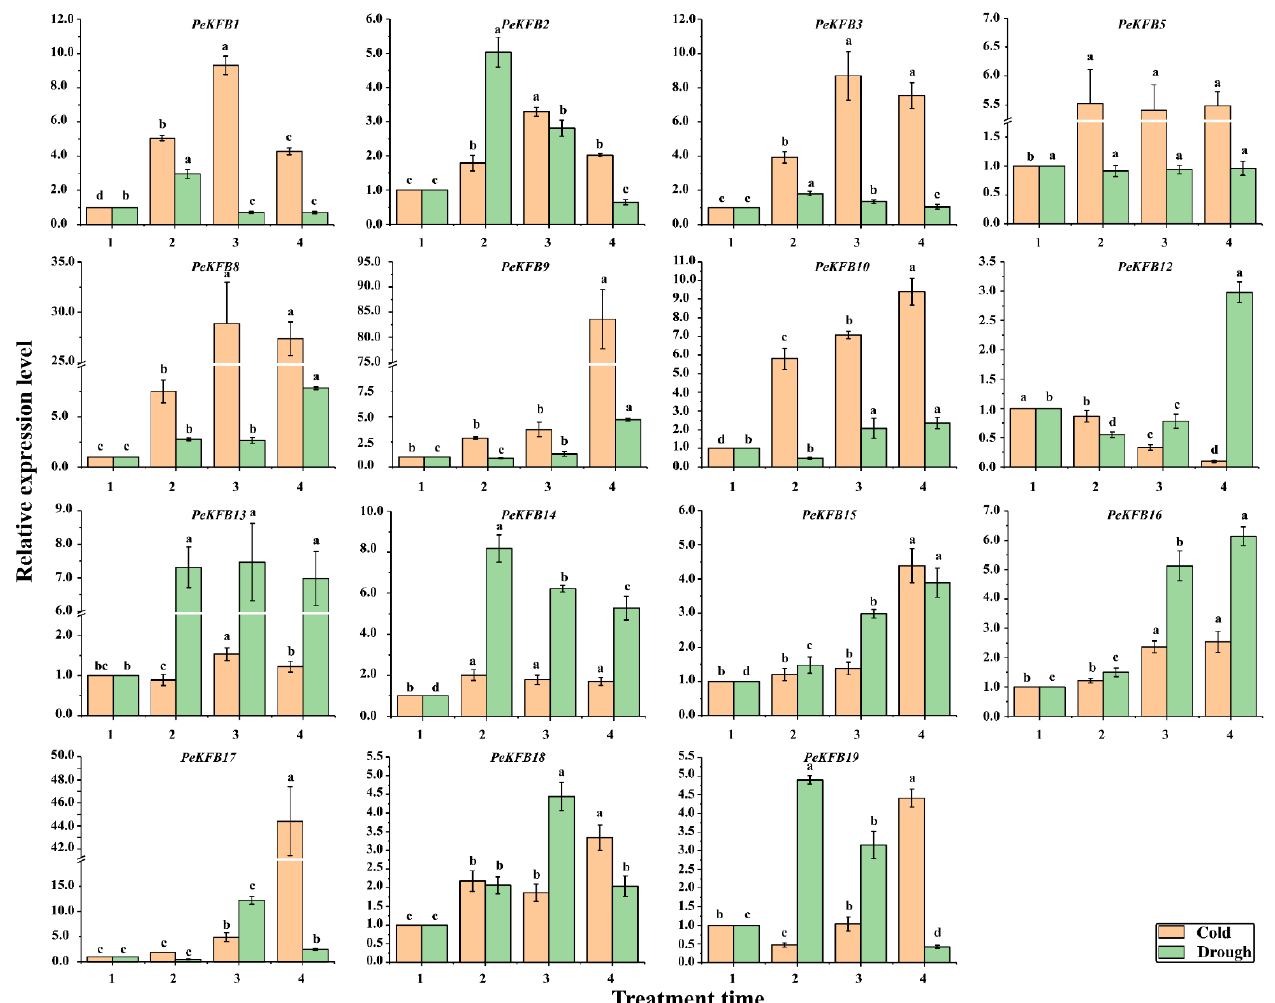
Figure 6. Expression patterns of PeKFB s in leaves of moso bamboo under low temperature and drought stresses. Different letters represent significant differences among different samples at p < 0.01. The average of three biological replicates along with the standard deviation (SD) are also given. The numbers 1, 2, 3, and 4 represent 0 h, 3 h, 6 h, and 12 h under stress treatments, respectively.